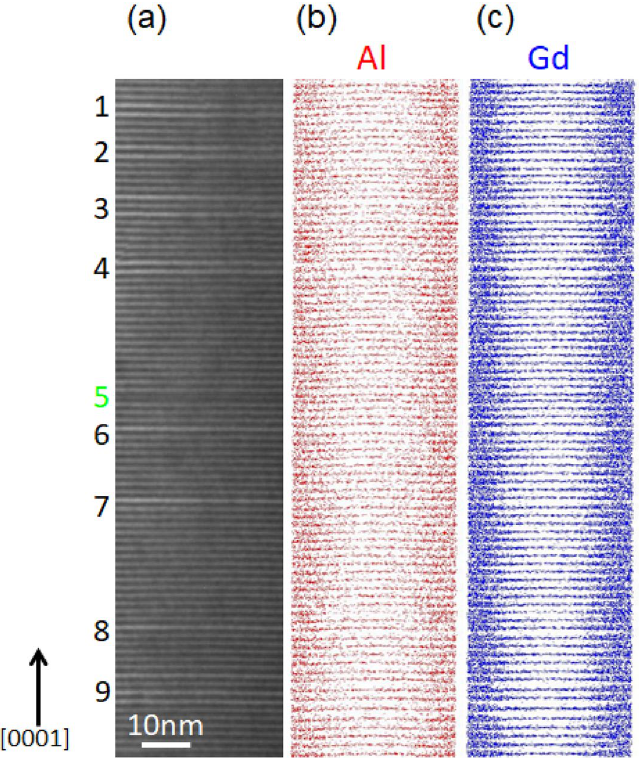
Figure 1. ( a ) TEM image (lattice fringe image by phase contrast). ( b , c ) 15-nm-thick sliced APT maps for Al and Gd in the same region of the TEM image. The vertical direction corresponds to the [0001] direction. This region includes local small part of 10 H and 14 H -type structure in the majority of 18 R -type LPSO/OD structure. Number indicates the irregular spacing of enriched layers corresponding to the 10H-type structure for #5 or 14 H structure for #1–4 and #6–9. Software: ( a ) Gatan Microscopy Suite (GMS), Ver. 2.30.542.0, https ://www. gatan .com/produ cts/tem-analy sis/gatan -micro scopy -suite -softw are, ( b , c ) Integrated Visualization and Analysis Software (IVAS), Ver. 3.6.14, https ://www.camec a.com/servi ce/softw